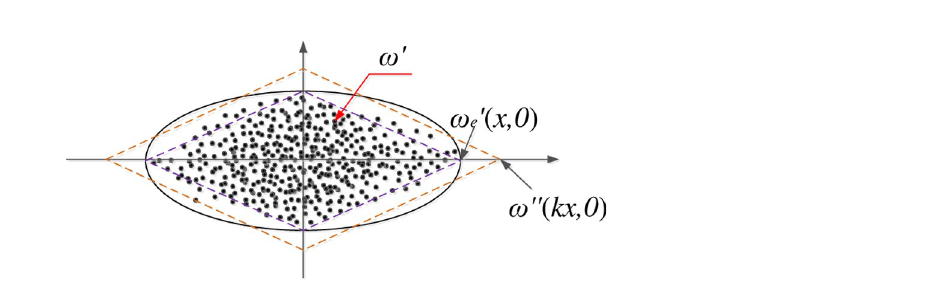
Fig 1. Standard ellipsoid based on historical data